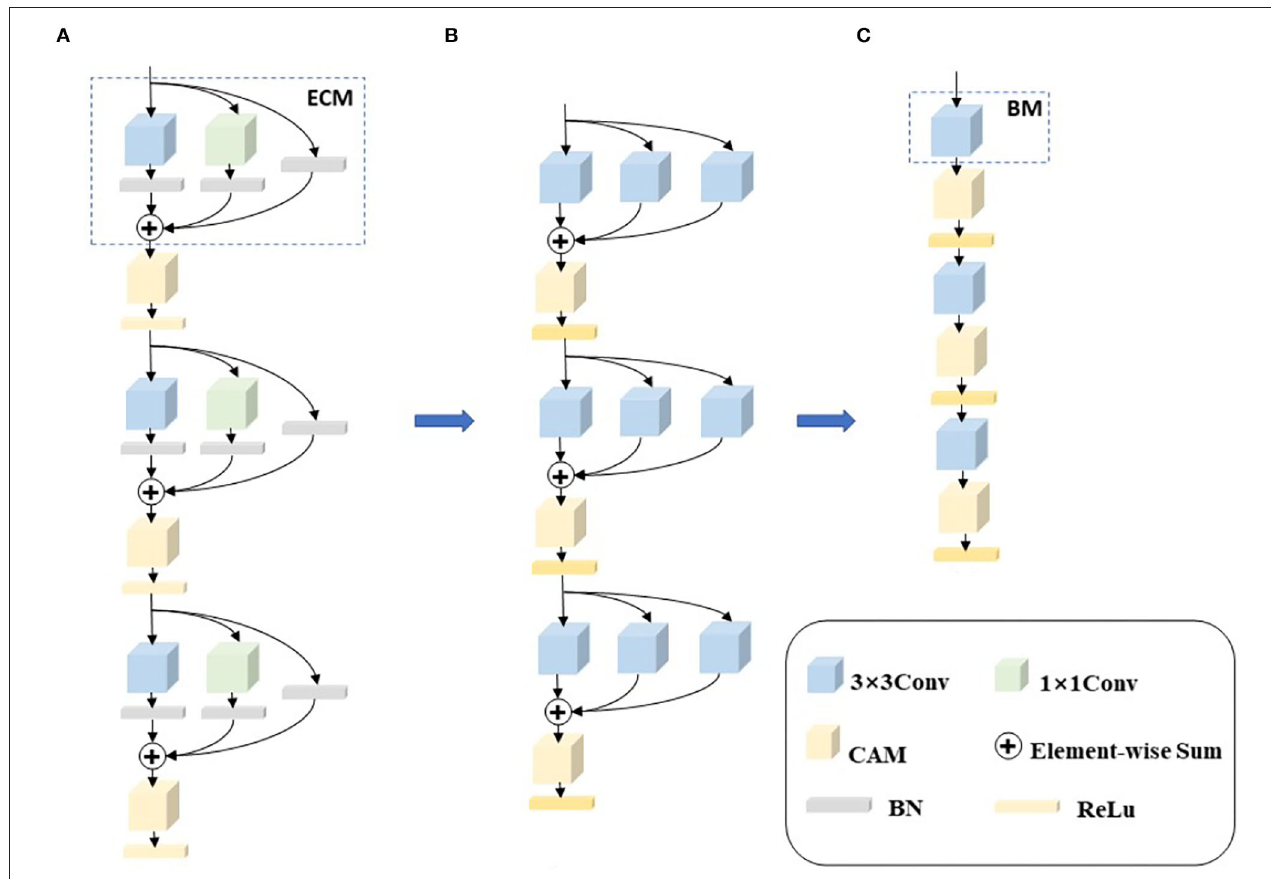
FIGURE 2 | The whole framework of re-parameterization. (A) Is a training network composed of enhanced revolution modules (ECM). (B) Is the re-parameterization process 1 × 1 convolution and skip connections are converted to 3 × 3 convolutions, and then the three convolutions are combined into one convolution through element-wise adding operations. (C) Is the deployment network composed of basic